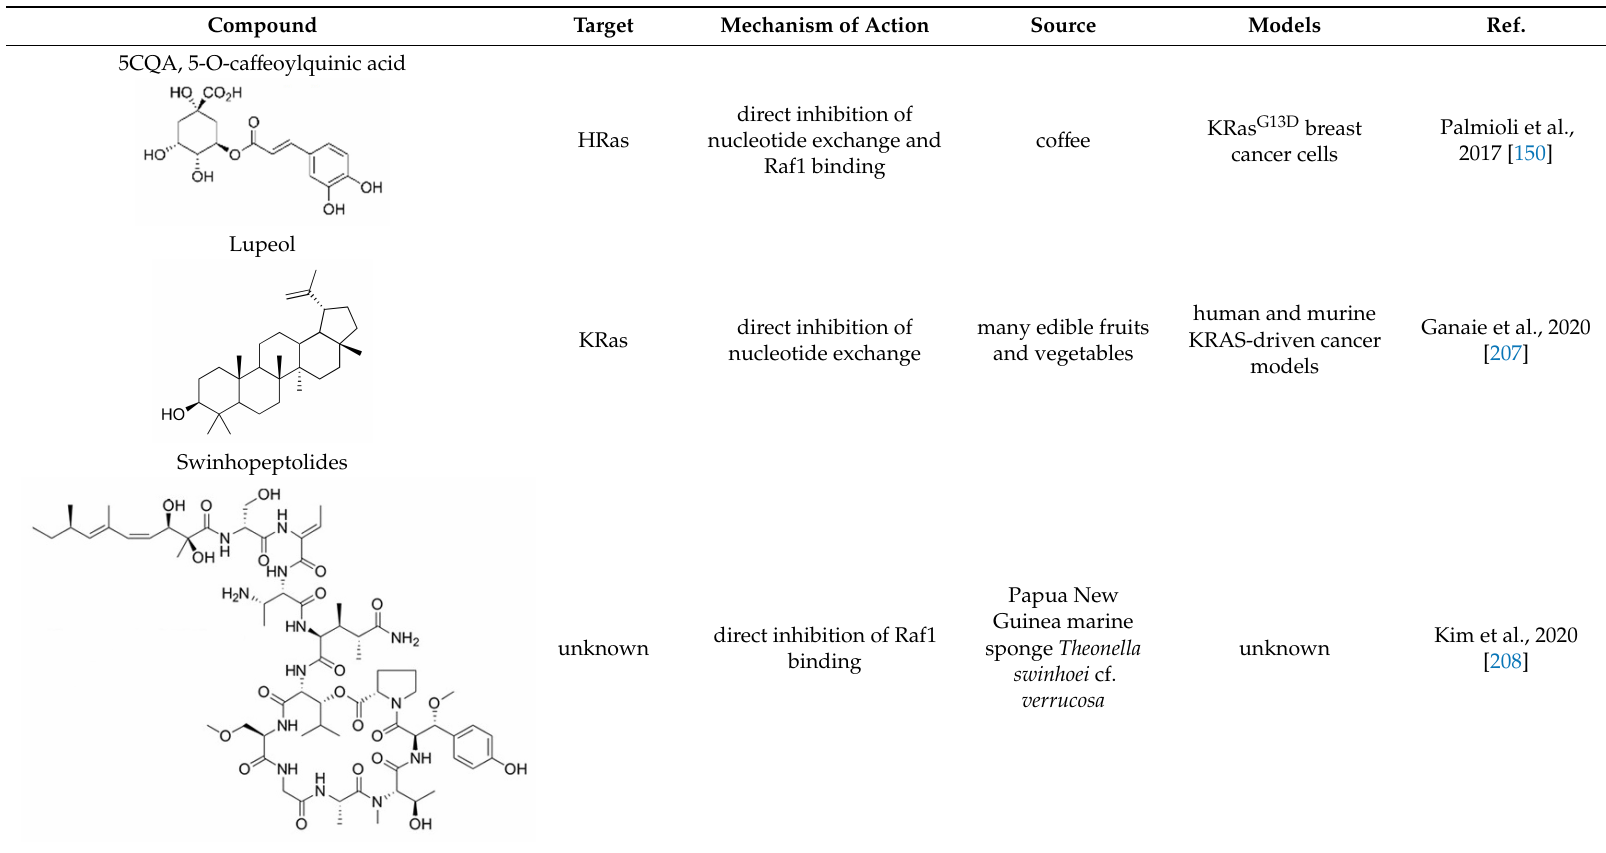
Table 3. List of natural compounds directly a ff ecting Ras oncoproteins